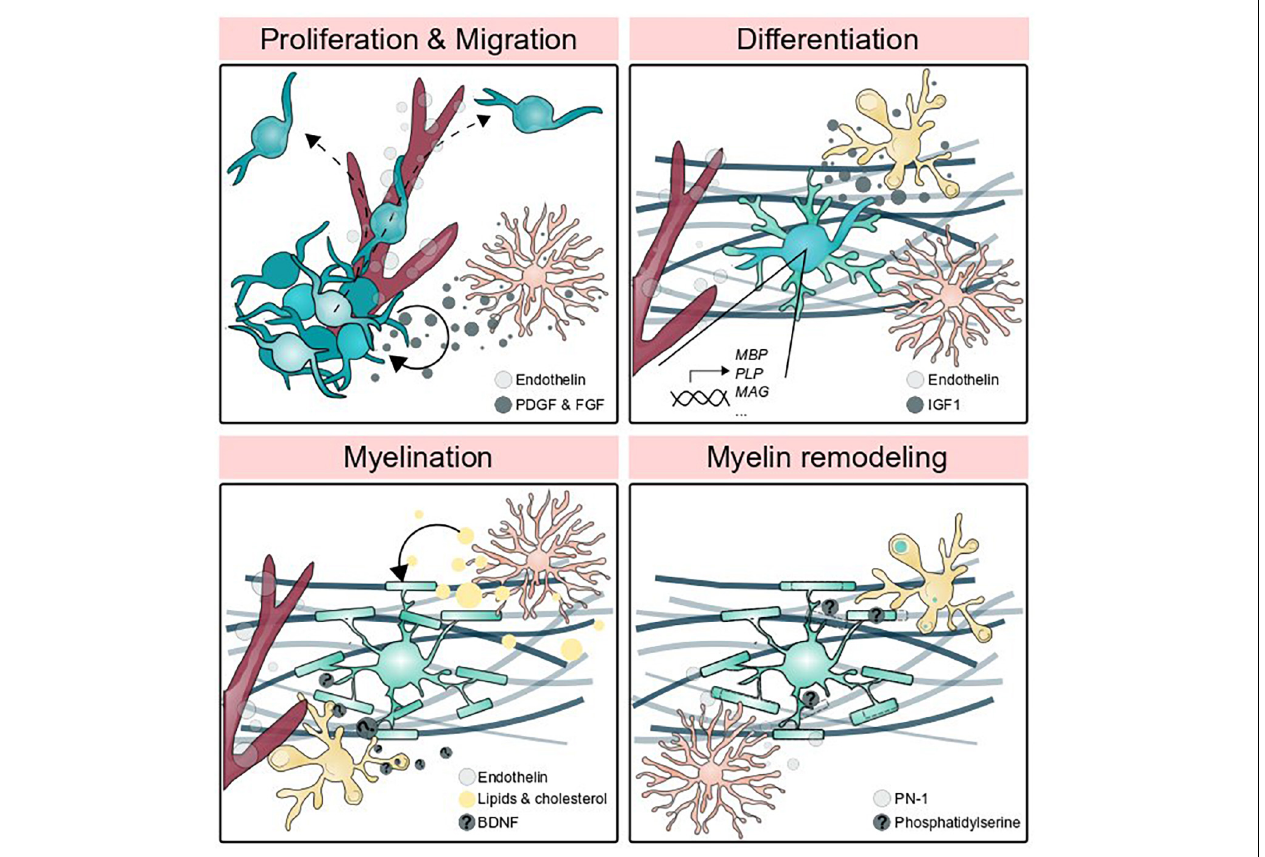
FIGURE 2 | Glial cells promote myelin formation and elimination. Oligodendrocyte precursor cell proliferation is promoted by astrocytic PDGF and FGF signaling and OPCs migrate along the vasculature. Endothelin secreted by endothelial cells and IGF1 secreted by microglia promote differentiation, and astrocytes guide OPCs to axons. The generation of myelin membrane (which may be thought of as one feature of differentiation) utilizes lipids and cholesterol produced by astrocytes, BDNF secreted by neurons and potentially augmented by microglia-secreted BDNF, and endothelin signaling to the receptor EDNRB located on oligodendrocytes. Astrocytic secretion of PN-1 promotes myelin stability by inhibiting thrombin-mediated paranodal lifting, whereas microglia phagocytose myelin by detecting